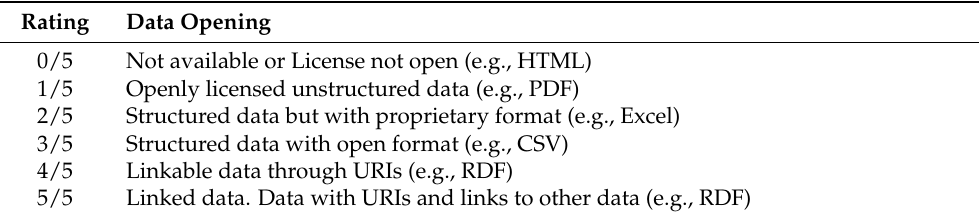
Table 1. Rating scale of sources according to the degree of